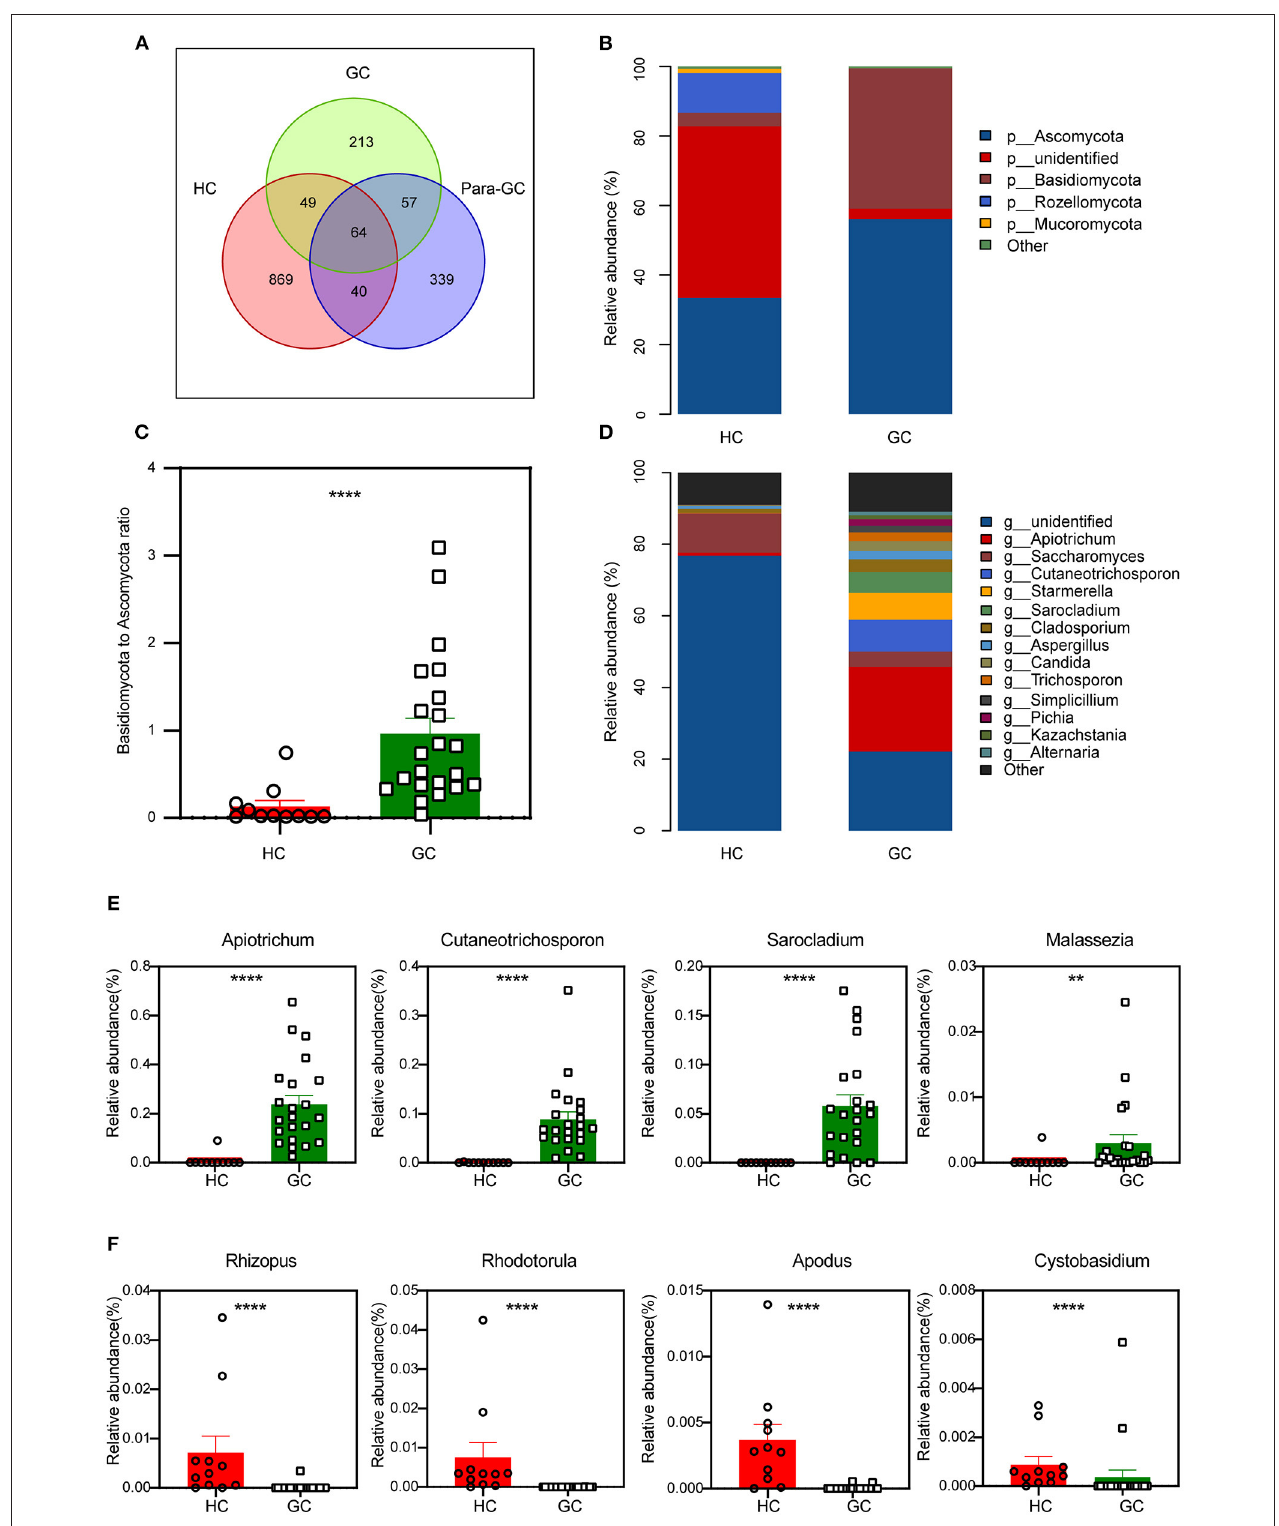
FIGURE 3 | Changes of the fungal composition. (A) Venn diagram analysis according to the operational taxonomic unit abundance among the three groups. (B) Comparisons of the relative abundance of dominant fungal taxa at the phylum level, “p” represents phylum. (C) The ratio of Basidiomycota to Ascomycota relative abundance between the two groups (Mann-Whitney U test, **** p < 0.0001). (D) Comparisons of the relative abundance of dominant fungal taxa at the genus level, “g” represents genus. (E,F) The differentially abundant fungal genus of GC-enriched (E) and HC-enriched (F) between HC and GC groups (Mann-Whitney U test, ** p < 0.01; **** p <